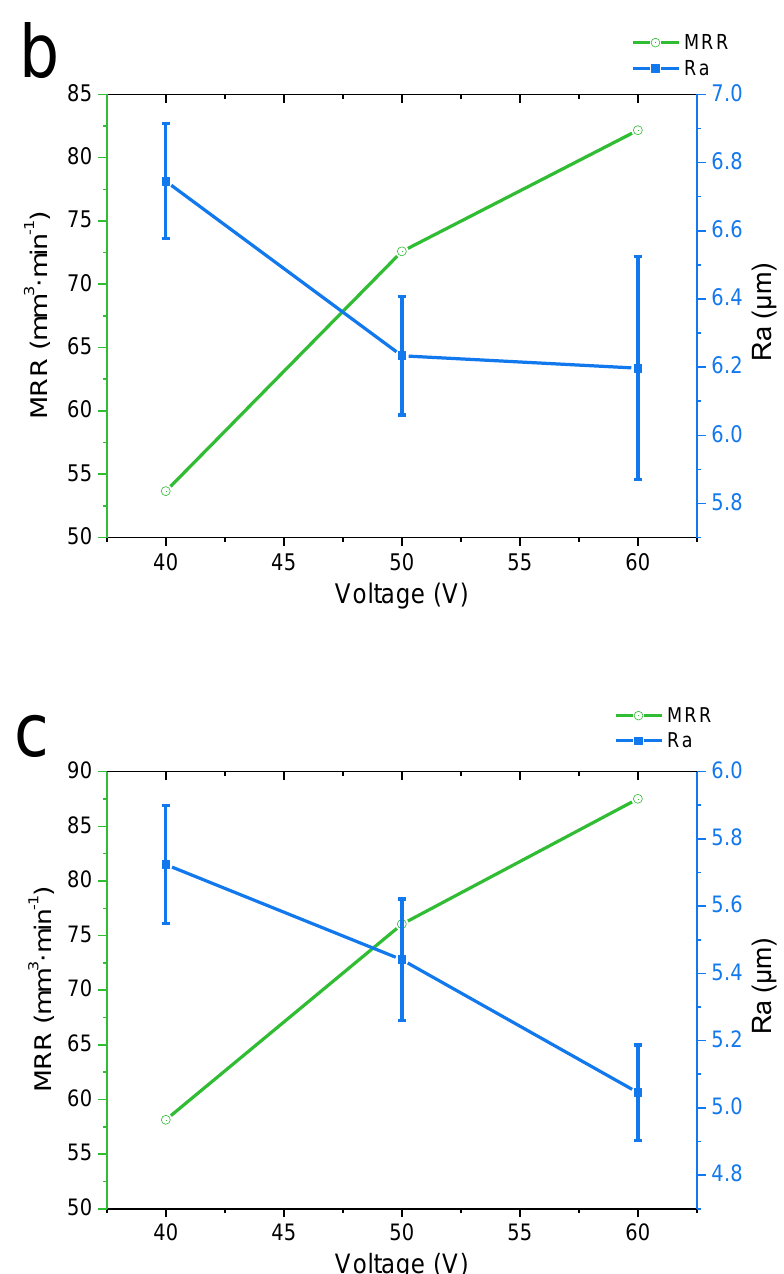
Figure 4. Material Removal Rate (MRR) and surface roughness (Ra) at different machining voltages. ( a ) Feed rate = 20 mm min − 1 , ( b ) feed rate = 30 mm min − 1 , and ( c ) feed rate = 40 mm min − 1 . Error bars represent the standard deviation of three individual measure results.